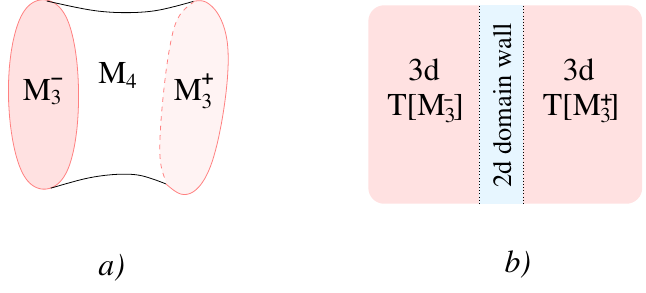
Figure 18 . ( a ) A cobordism between 3-manifolds M (cid:0) theory T [ M 4 ] on the domain wall (interface) coupled to 3d N = 2 theories T [ M (cid:0) both sides